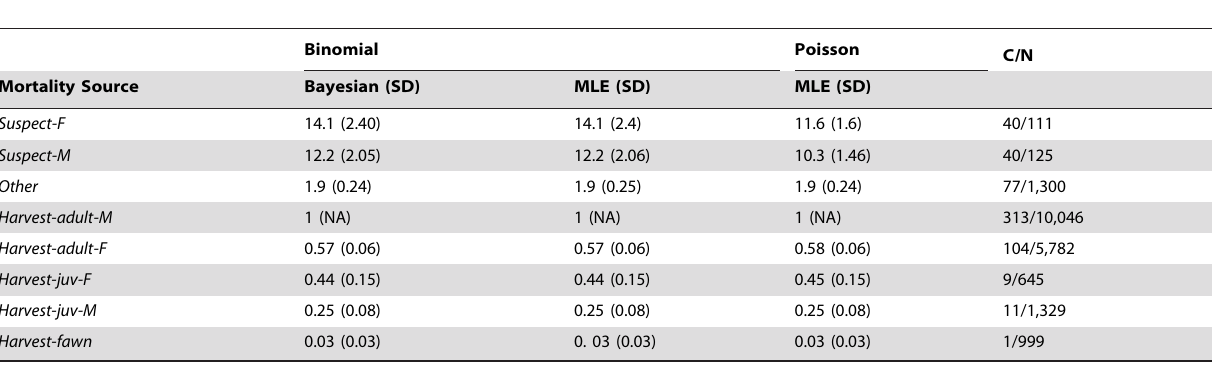
Table 1. Estimates of nominal CWD surveillance weights for 8 classes of mule deer from Colorado (data from WM[15]) using a binomial complementary log-log regression model with Bayesian and maximum likelihood approaches, as well as a Poisson regression model.